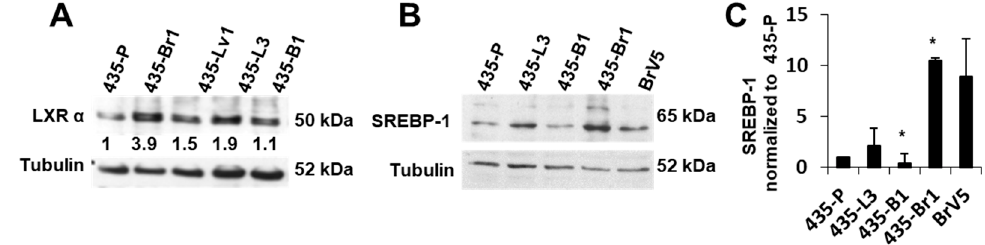
Figure 3. BrM cells upregulate genes involved in FA synthesis. ( A,B ) Immunoblotting of LXR α ( A ) SREBP-1 ( B ) in metastatic variants. ( C ) SREBP-1 expression was quantified vs. tubulin and normalized to 435-P cells. Error bars represent SEM of three independent experiments. Significance determined with t -test. * p < 0.05.